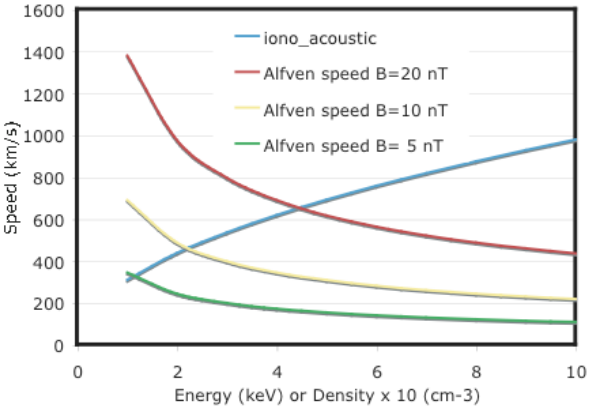
Figure 3. Iono-acoustic and and Alfven velocities as a function of plasma parameters. The energy scale refers to the iono-acoustic velocity while the plasma density to the Fig. 3. Iono-acoustic and and Alfv´en velocities as a function of Alfven Wave curves. Plasma sheet densities at >8Re are usually less than 1 cm -3 plasma parameters. The energy scale refers to the iono-acoustic ve- (labeled as 10). locity while the plasma density to the Alfv´en Wave curves. Plasma sheet densities at > 8 R E are usually less than 1cm − 3 (labeled as In calculating the Alfven speed we used a combination of the IGRF internal reference 10). field combined with the Tsyganenko 1989 external field in a low magnetic activity condition. Within the neutral sheet itself the B x component is very small and the models show that x>10 Re the V FM is dominated by the ion-acoustic speed. We have used a constant plasma density of 0.3 cm -3 . This is consistent with THD and THE density measurements. kT seen by this satellite was approximately 2000 to 3000 eV, which would yield an ion acoustic speed estimate of about 500 km/s. The assumption of using the Alfven/Magnetosonic speed itself can also be questioned on account of plasma inertia and the cumulative effects of reconnection forces. It is hard to know what the average propagation speed of these features is from the location of their generation to the probes where they were measured. Propagation speeds can be estimated from the measured ion speeds at THA, THD, at the time of dipolarization. From the flow velocity measurements